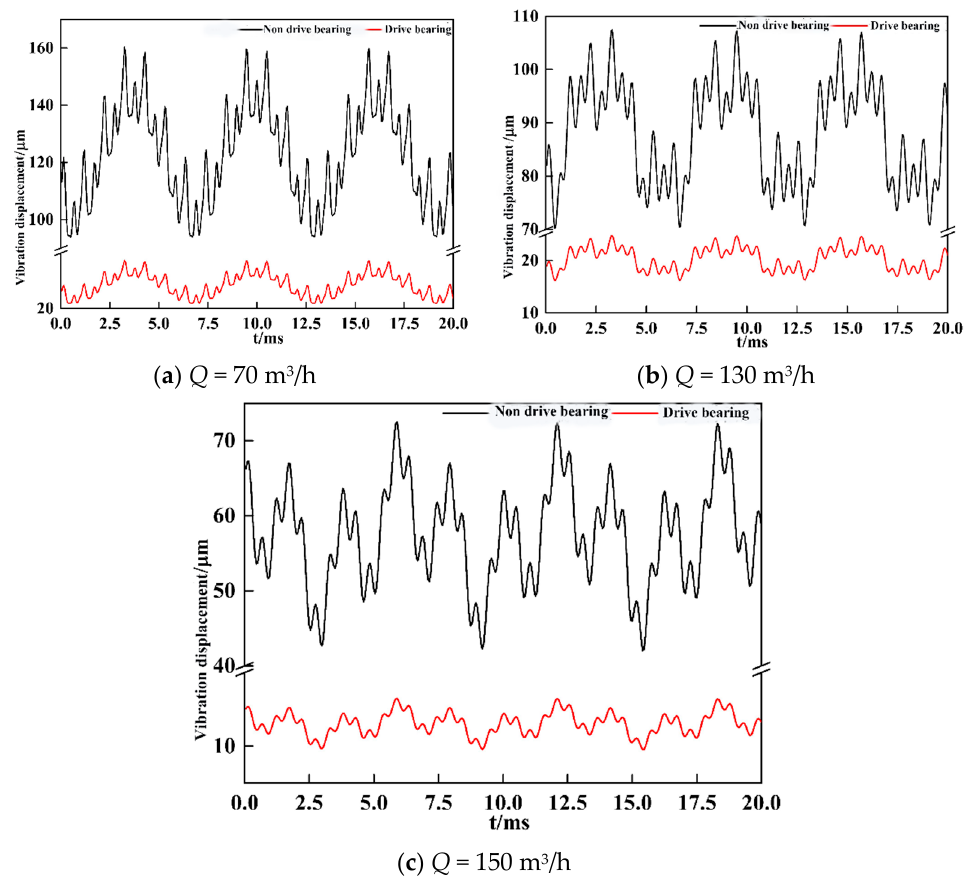
Figure 15. Vibration displacement at different flow rates.